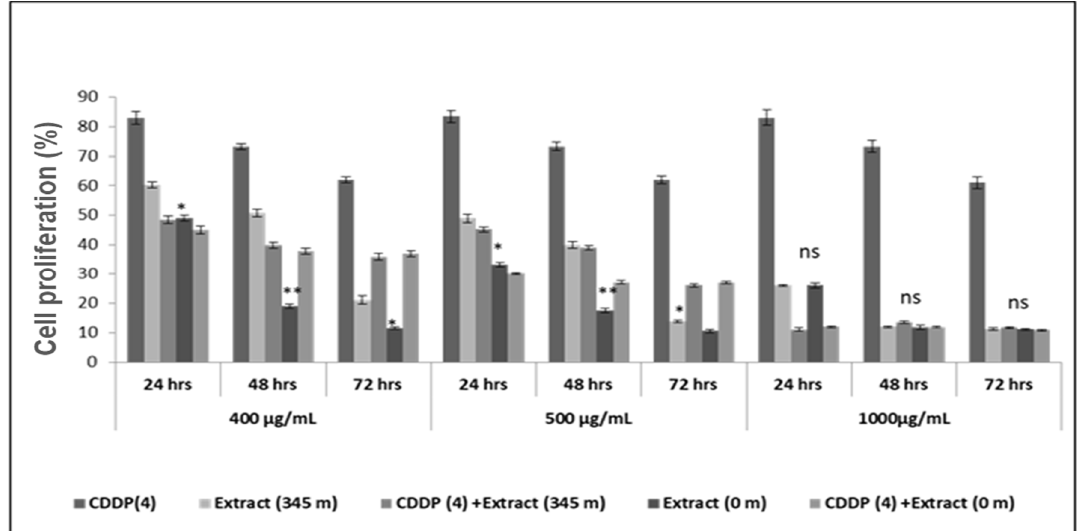
Figure 8. Comparison between the cell proliferation of A549 cells after treatment with CDDP, water extract, and a combination of both at 24, 48, and 72 h. Peak values are represented as mean +/ − SD. Statistical analysis: Unpaired t test or Mann–Whitney test. * p < 0.05; ** p < 0.05 in which percentage of proliferation of cells treated with 0m extract is compared to that of cells treated with 345 m extract. Statistical analysis: Paired t test or Wilcoxon test. * p < 0.05; ** p < 0.05 in which percentage of cell viability of cells treated with CDDP–extract is compared to that of cells treated with extract alone. ns refers to non-significant results.